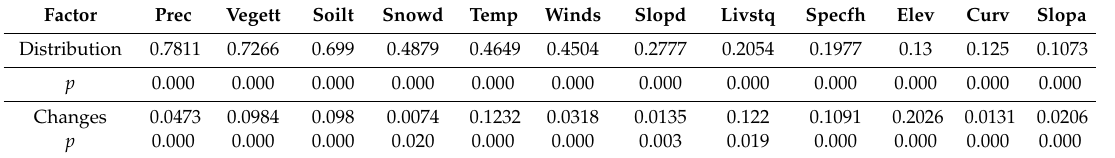
Table 3. The q value and p value of all factors for NDVI distribution and